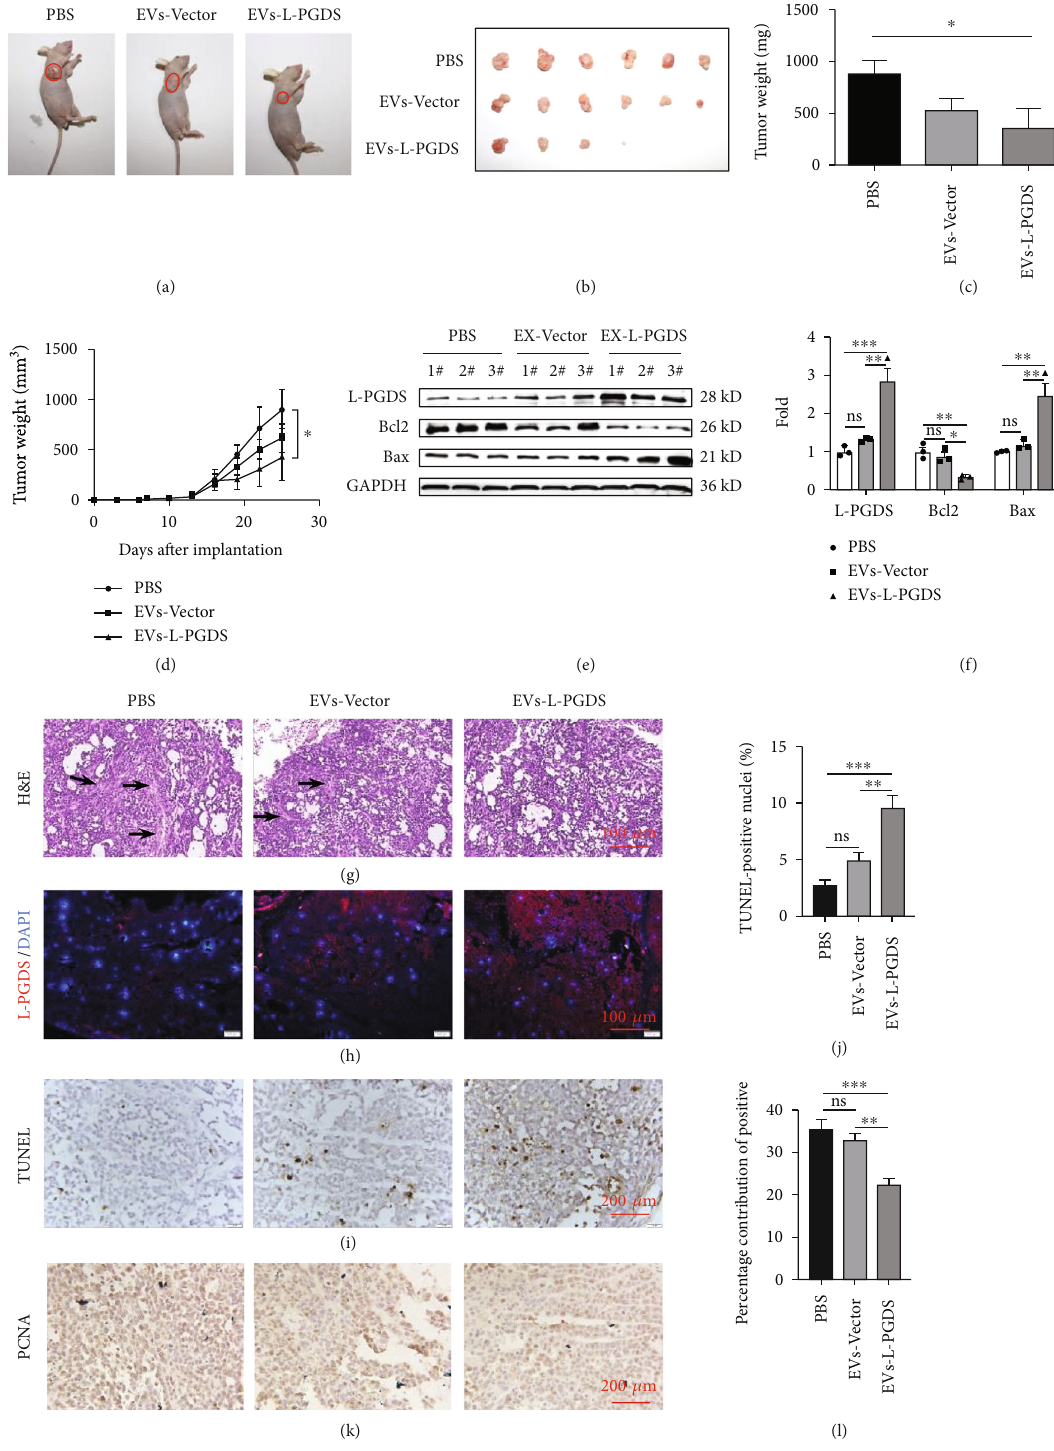
Figure 5: EVs-L-PGDS inhibited the growth of subcutaneous tumors in nude mice induced by gastric cancer cell SGC-7901. (a) Representative images of tumor-bearing mice. (b) Representative view of subcutaneous tumors. (c, d) Weight statistics and volume changes of tumor in mice treated with di ff erent EVs and PBS. (e) Western blot for the expression of L-PGDS, Bcl2, and Bax in tumor tissues. (f) Quantitative analyses of protein expression of tumor tissue. (g) HE staining of tumor tissues ( × 100). Arrowheads point to blood vessels. (h) Immuno fl uorescence staining for the expression of L-PGDS in tumor tissues ( × 100). (i) TUNEL assay for the apoptosis level in tumor tissues ( × 400). (j) Quantitative analyses of TUNEL-positive cells in tumor tissue. (k) Immunohistochemical staining for the expression of PCNA in tumor tissues ( × 400). (l) Quantitative analyses of PCNA expression in tumor tissue. n = 6 ; ∗ P < 0 : 05 , ∗∗ P < 0 : 01 , and ∗∗∗ P < 0 : 001